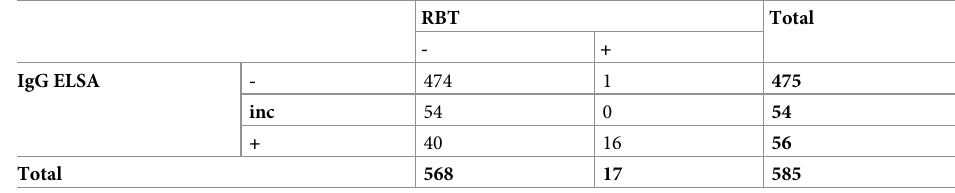
Table 6. Comparison of IgG ELISA and RBT results in persons in direct contact with large ruminants. RBT Total IgG